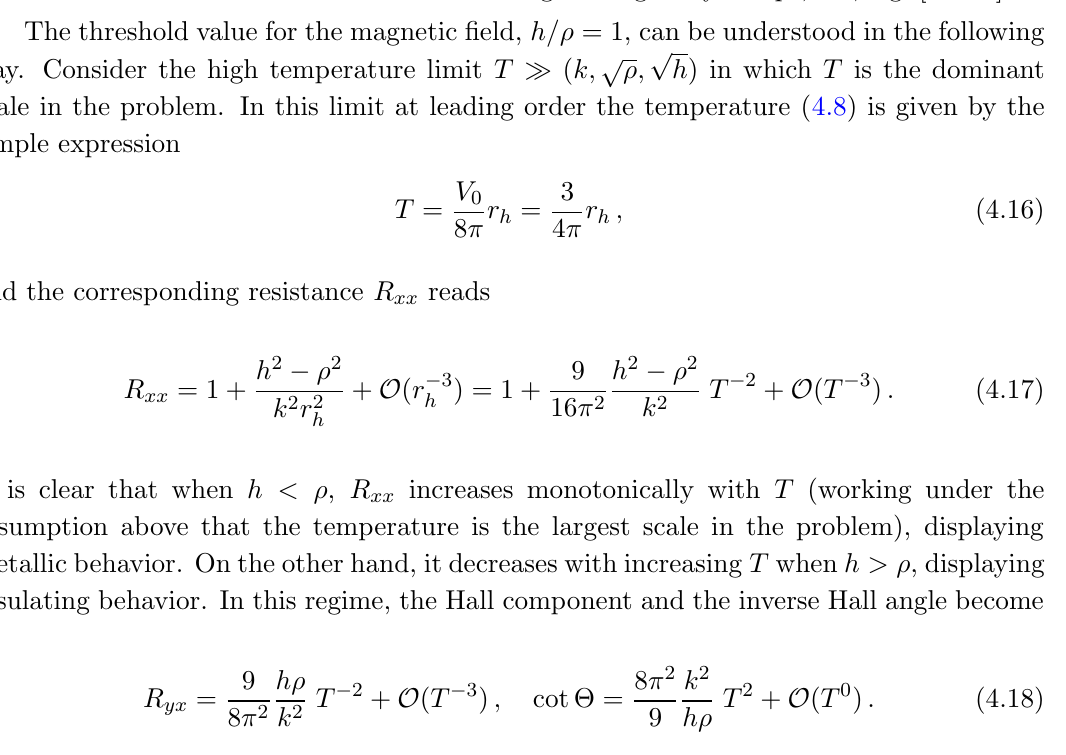
Figure 4 . The resistance R xx at (cid:12)nite charge density versus h=(cid:26) and T= momentum dissipation parameter k= correspond to decreasing values of h=(cid:26)